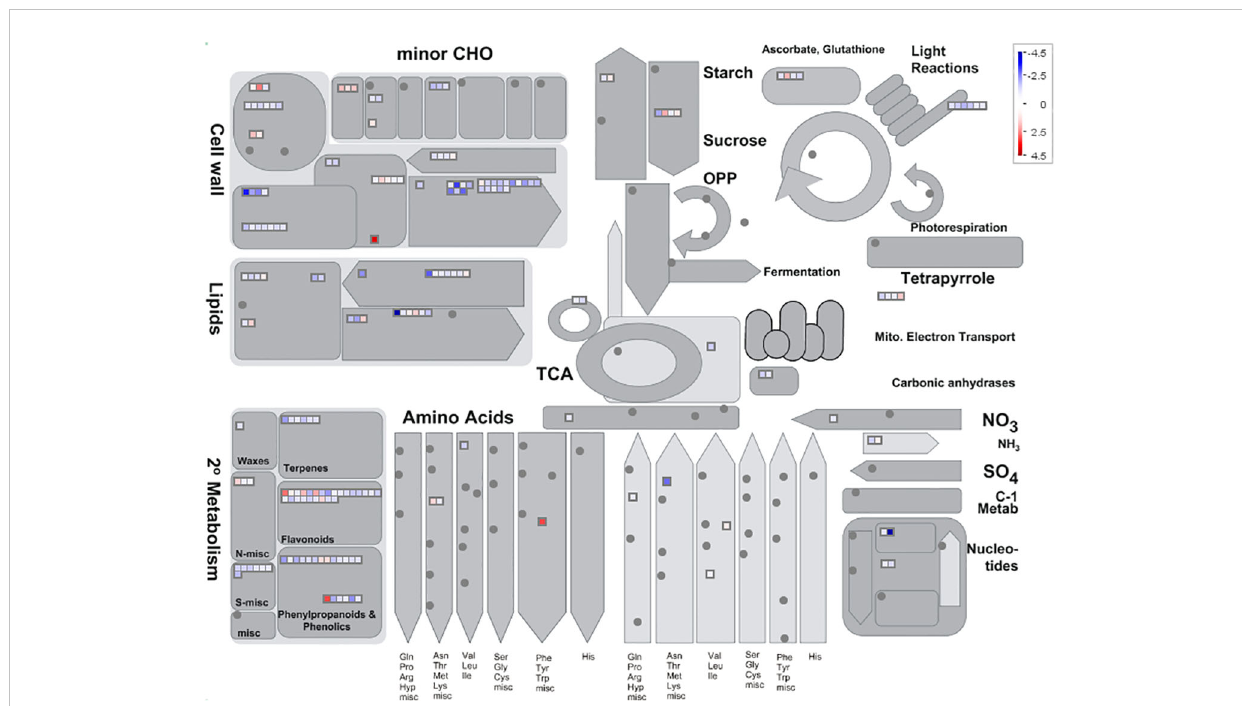
FIGURE 4 Metabolic pathways with different expression pro fi les in the pHB-MeGI and pHB-empty lines (blue, pHB-empty biased; red, pHB-MeGI biased). Each square represents a differentially expressed gene (DEG). See Usadel et al. (2009) for more information concerning interpretation of the MAPMAN